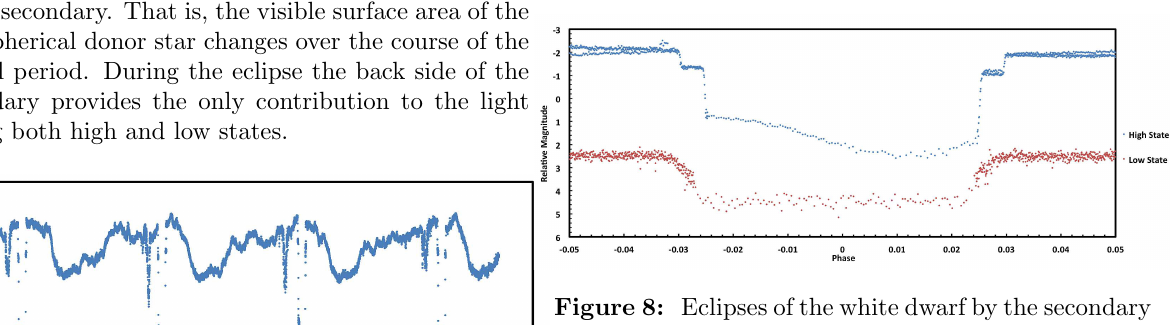
Figure 8: Eclipses of the white dwarf by the secondary star are shown for the high state (top - red points) and low state (bottom - blue points). The orbital phase is shown, with phase 0 being the time of